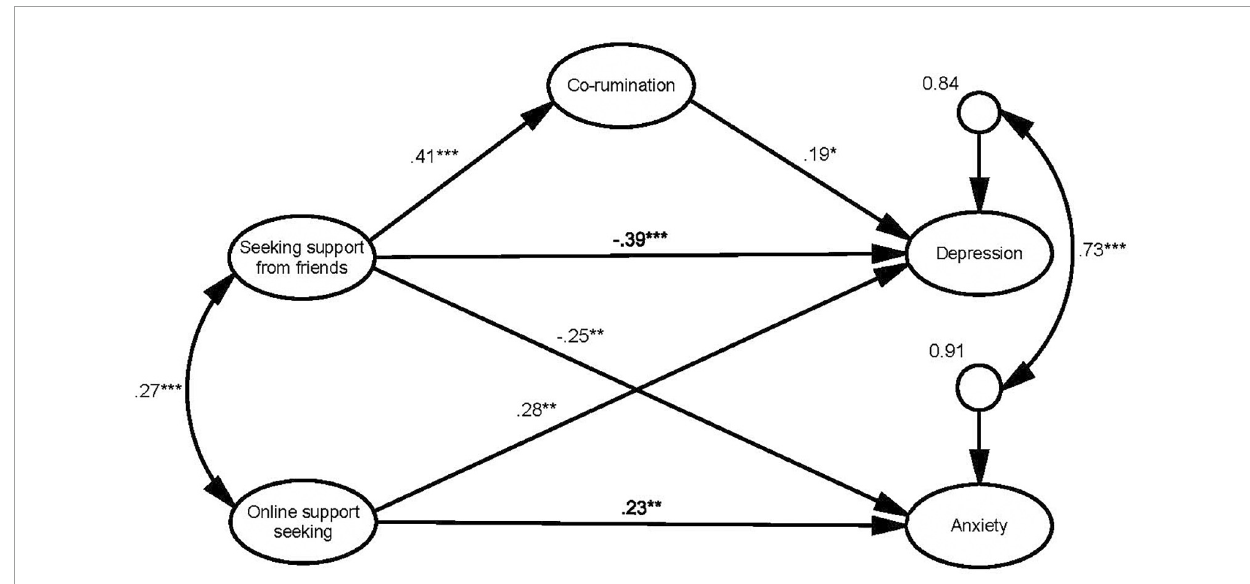
FIGURE1 Structural model with standardized path coefficients (significant paths only). Indicators and uniquenesses are omitted for clarity; *significant at the 0.05 level (2-tailed); **significant at the 0.01 level (2-tailed); ***significant at the 0.001